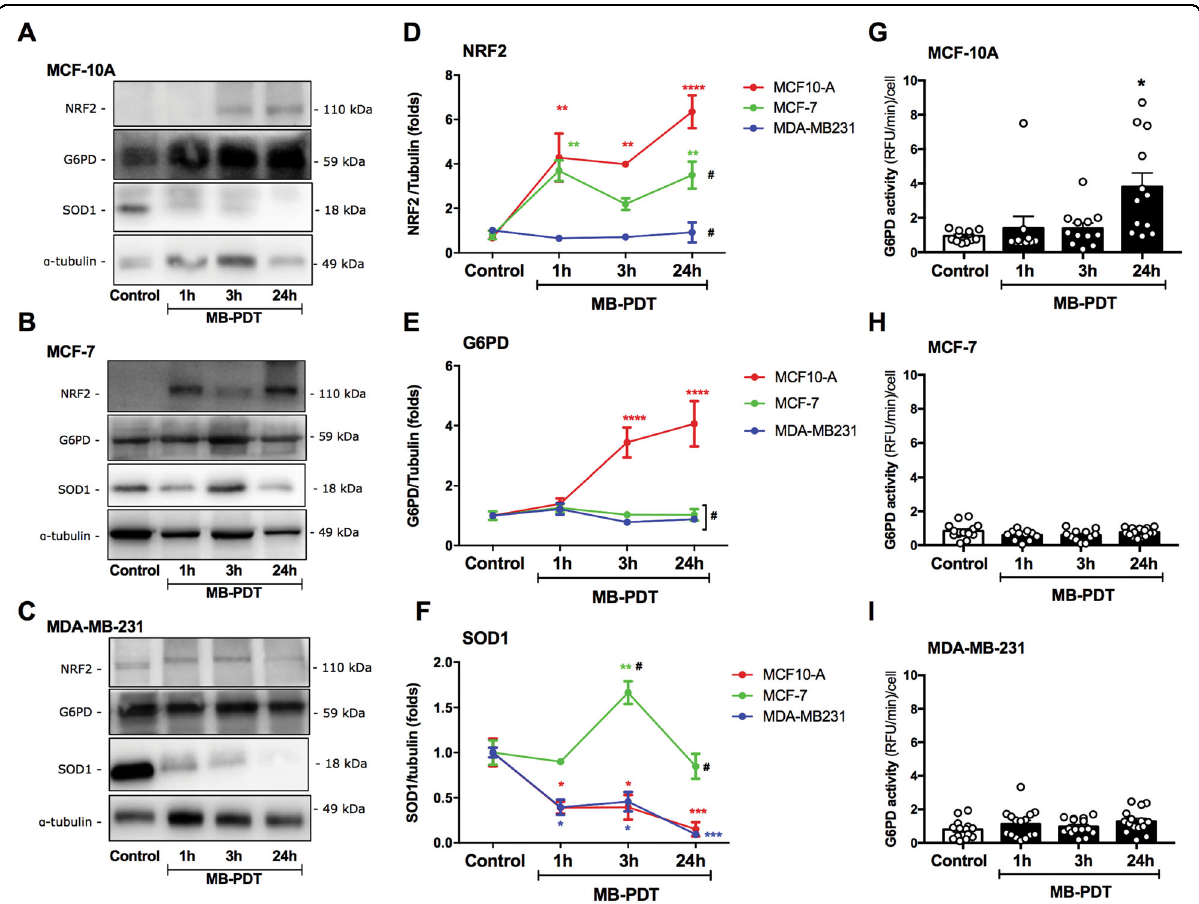
Fig. 3 Non-tumorigenic breast cells display antioxidant response to MB. Representative images of western blottings of NRF2, G6PD, and SOD1 for each BC after being submitted or not with MB-PDT: A MCF-10A, B MCF-7, and C MDA-MB-231. Western blotting quanti fi cations of D NRF2, E G6PD, and F SOD1 of each BC treated or not with MB-PDT (PDT). Results are presented as folds vs. Control condition. Color representation: MCF-10A in red, MCF-7 in green, and MDA-MB-231 in blue. G6PD activity in G MCF-10A, H MCF-7, and I MDA-MB-231 cells after being submitted or not to MB- PDT (PDT). n ≥ 3 independent experiments. **** p < 0.0001, *** p < 0.001, ** p < 0.005, * p < 0.05 vs. Control; # p < 0.05 vs. MCF-10A at each time point. Results are presented as mean ±